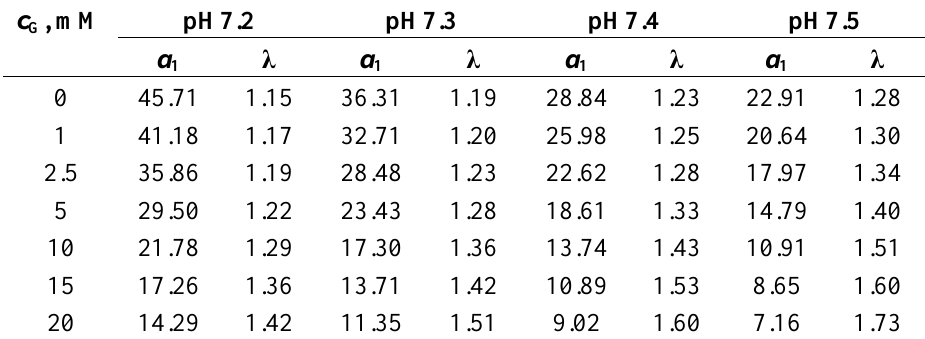
Table C3. Values of a and λ for the different glucose concentrations c 1 with I = 0.15 M and with the different pH values for the investigated AAm/3-